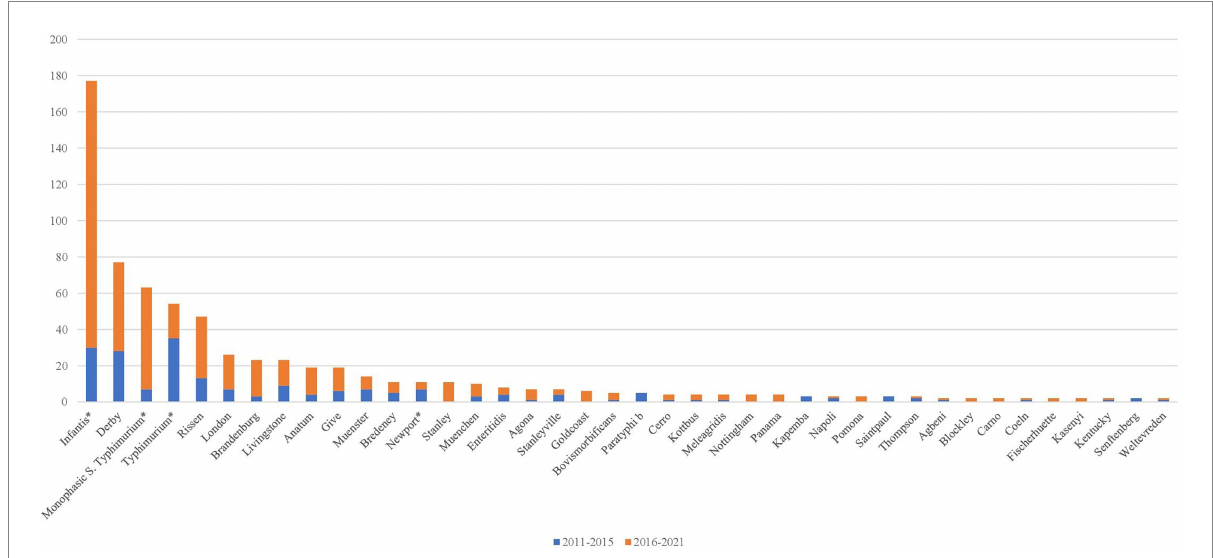
FIGURE 1 Number of Salmonella serovars within the subspecies enterica isolated with an occurrence >1 from 2011 to 2021. The asterisk (*) indicates the significant differences between the two sampling periods (2011–2015 vs. 2016–2021; p <